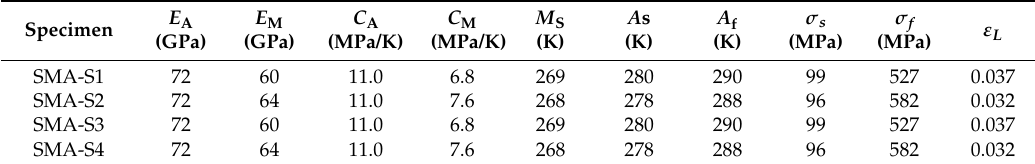
Table 3. Material properties of the SMA wires.